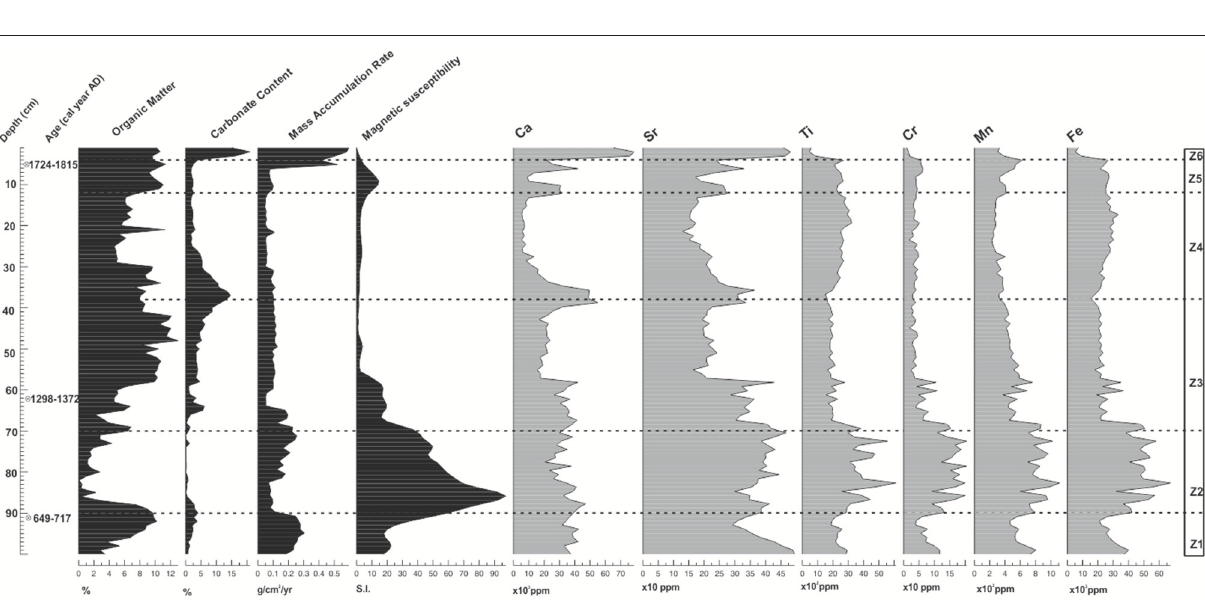
FIGURE 4 | Chemical elements resulted from XRF analysis, Magnetic susceptibility (MS), Organic Matter Content (OM), Carbonate Content (CC), and Mass Accumulation Rate (MAR) for the core S1M1 retrieved from the Cuyutlan Lagoon in the Pacific coast of Mexico. Divisions are delineated by zones according to the optimal splitting option available in PSIMPOLL 4.27(Bennett, 2009). Dates on the Y-axis are calibrated yr